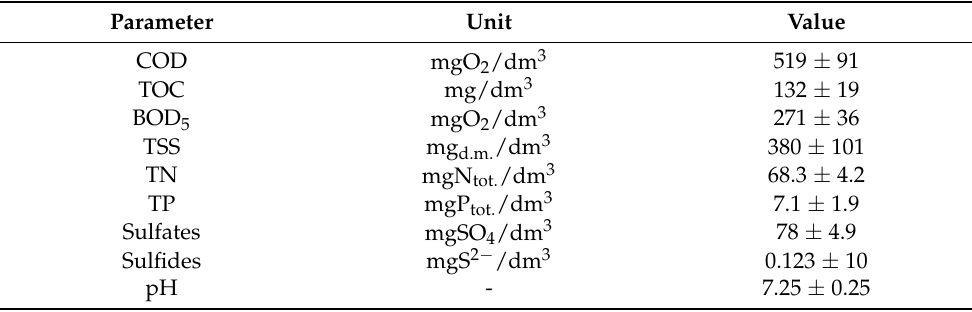
Table 2. Characteristics of the municipal wastewater used in the